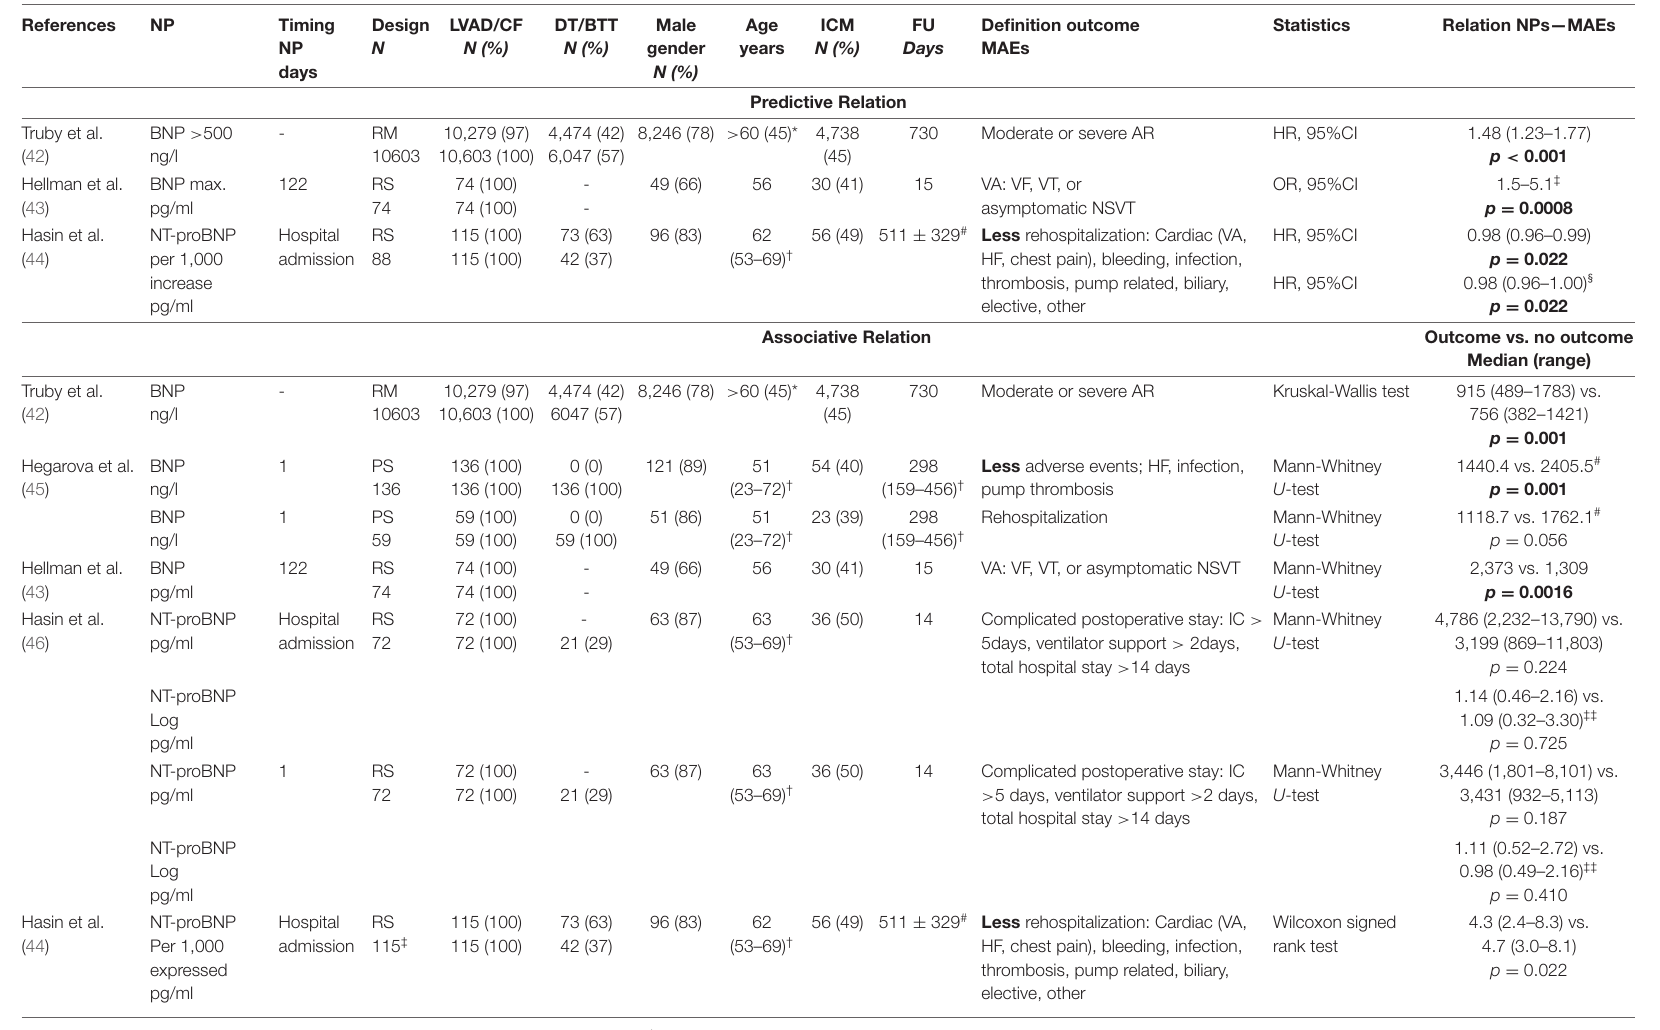
TABLE 4 | Baseline characteristics and outcomes of included studies for major adverse